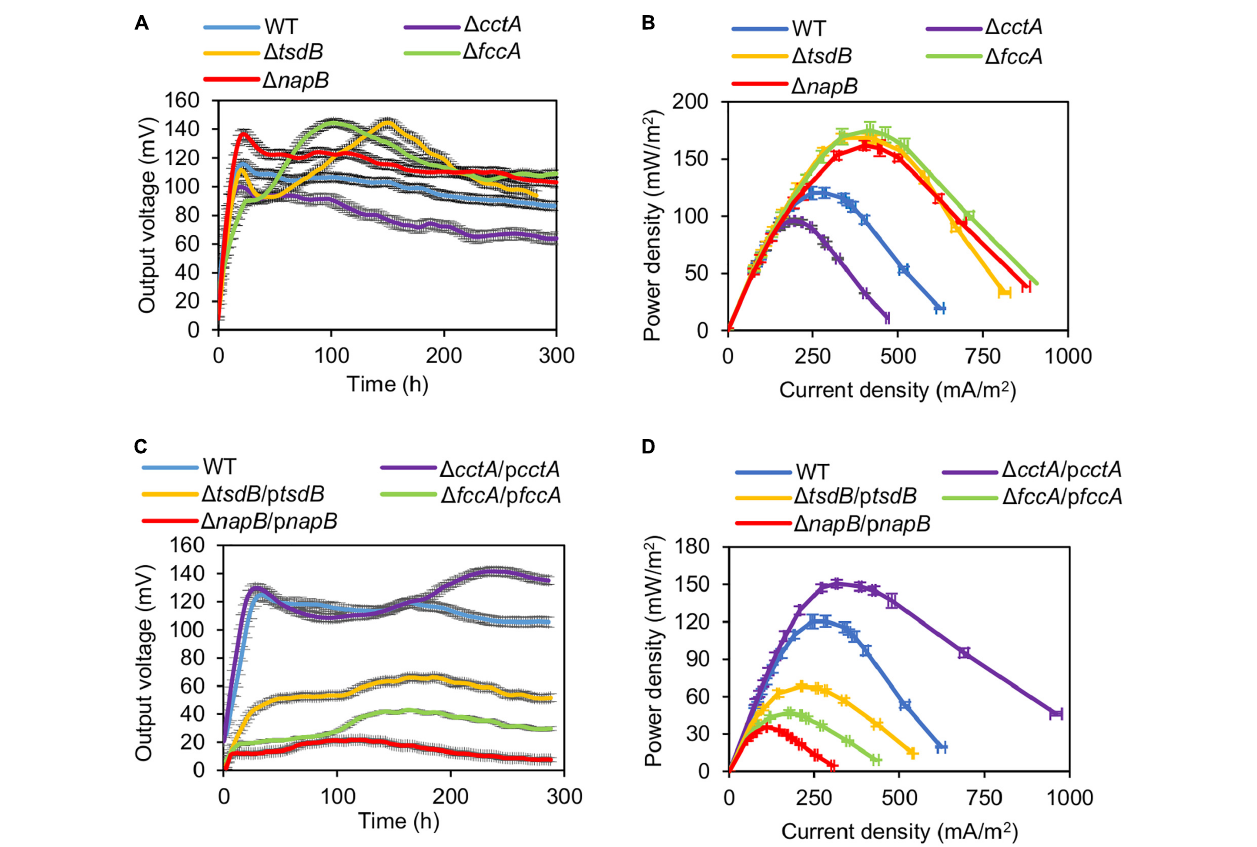
FIGURE 4 | Bioelectrochemical characterization of periplasmic c -Cyt mutants in dual-chamber MFCs. Data from WT and indicated periplasmic c -Cyt mutants w/o complementation with 0.5 mM IPTG are shown. (A,C) Output voltage of MFCs incubated with the indicated strains across the 2,000 (cid:127) external resistor. (B,D) Power density curves determined by measuring the stable output voltage generated across various external resistances. Three independent operations were performed, and data are presented by the means ± SD. In all panels, the differences in the peak values between WT and each of periplasmic c -Cyt mutants under test were <